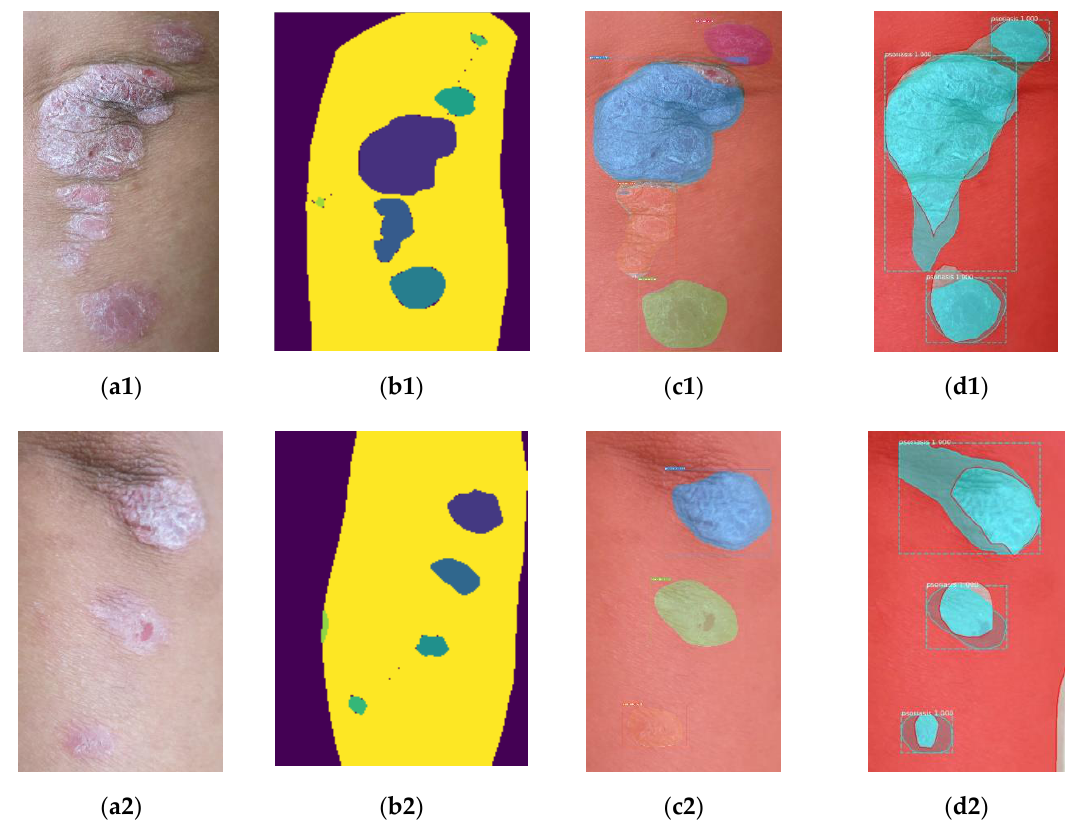
Figure 12. Instance segmentation result for local regions: ( a1 , a2 ) Input, ( b1 , b2 ) ground truth, ( c1 , c2 ) proposed, and ( d1 , d2 ) Mask R-CNN.